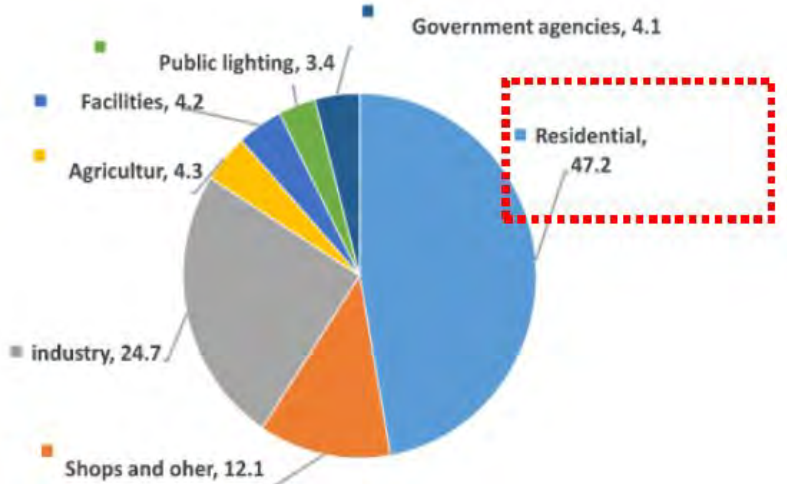
Figure 1. Electricity use by sector in the Egyptian market 2015-2016 (“Egyptian electricity holding company annual